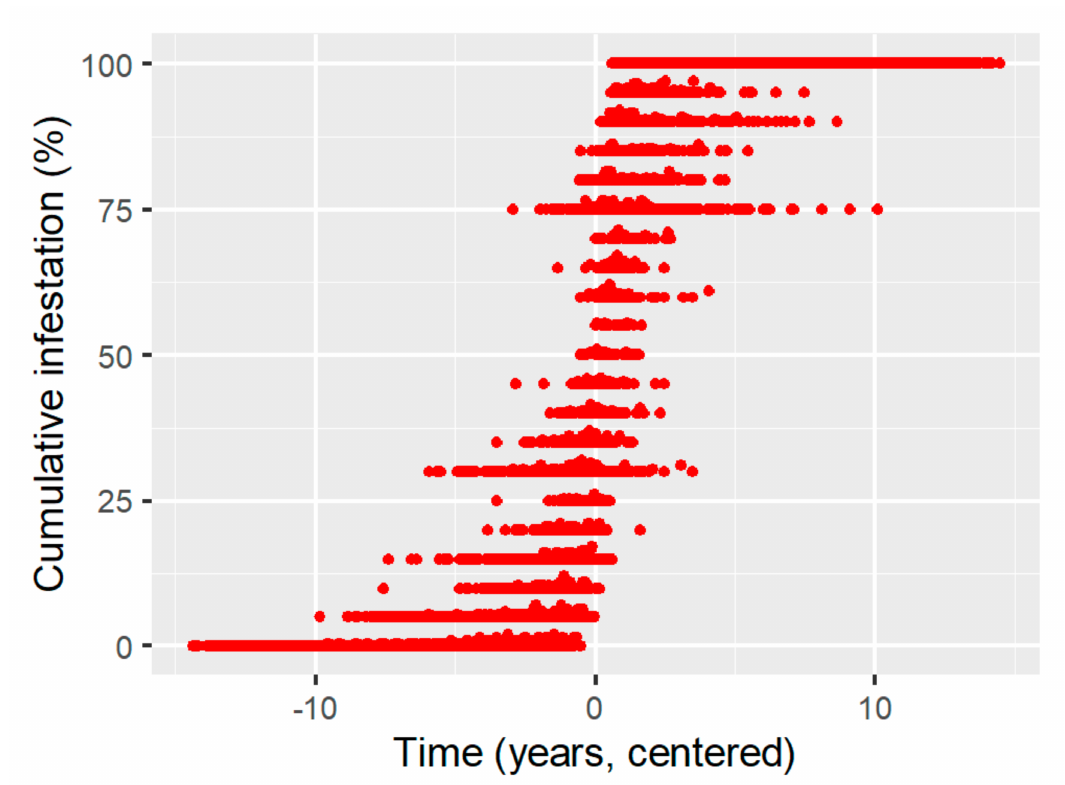
Figure A2. O ff set-corrected cumulative infestation data